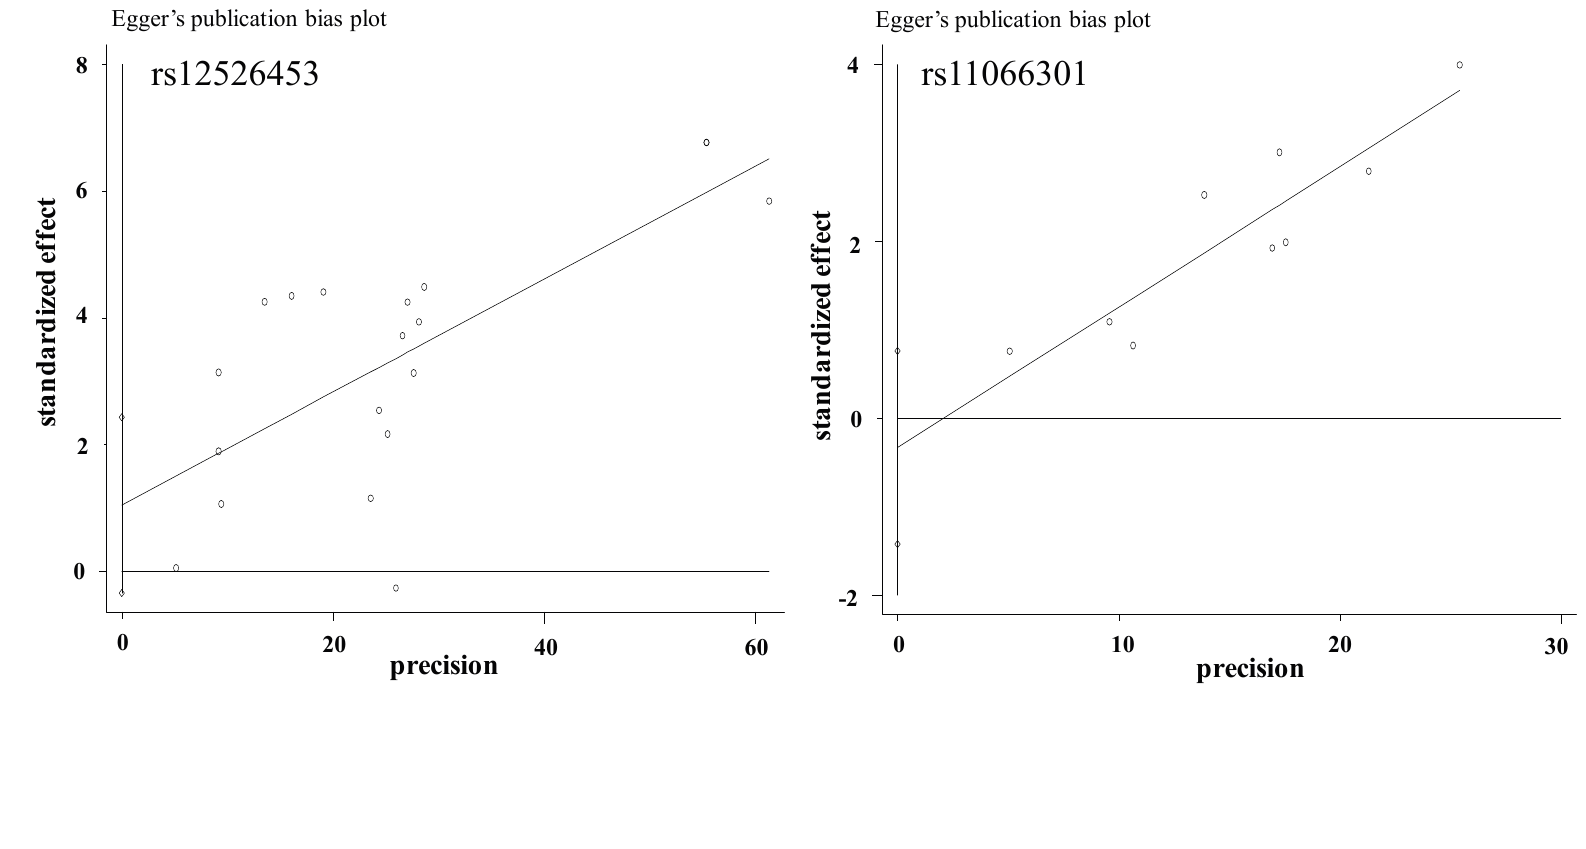
Figure 5. Egger’s publication bias plot for the relationship between the two SNPs and CAD in the